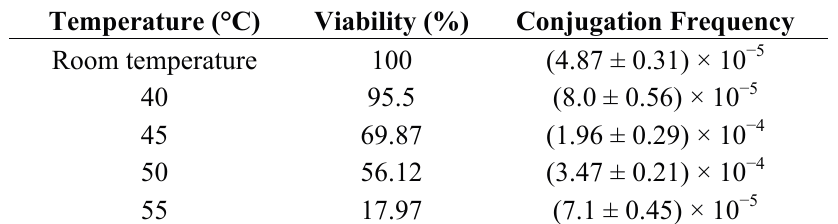
Table 1. Effect of heat treatment of S. noursei xinao-4 spores on spore viability and conjugation efficiency with E. coli ET12567 (pUZ8002/pSET152) on 2CMY agar medium containing 10 mM MgCl 2